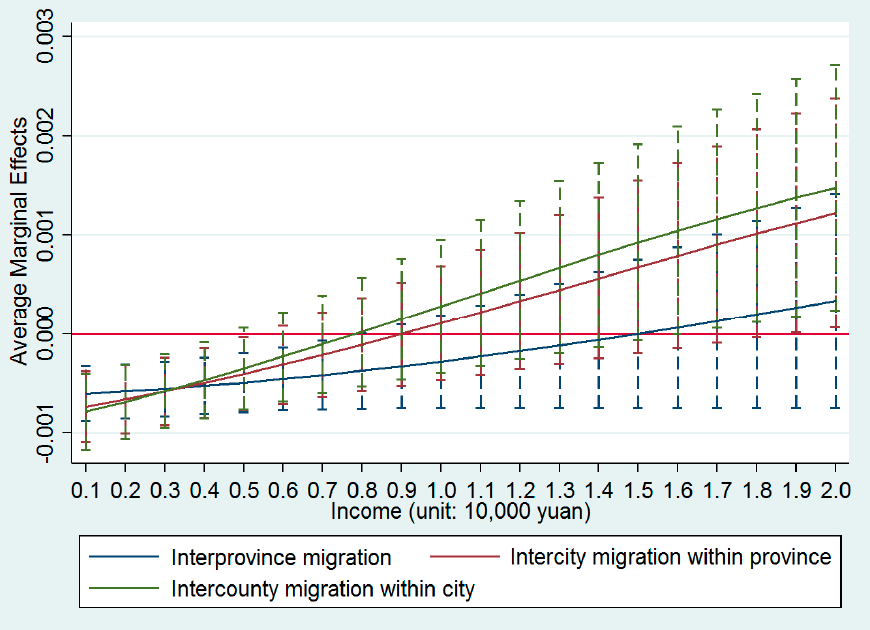
Figure 3. Average marginal effects of PM2.5 with 90% confidence intervals for migrants migrating over different migration distances.